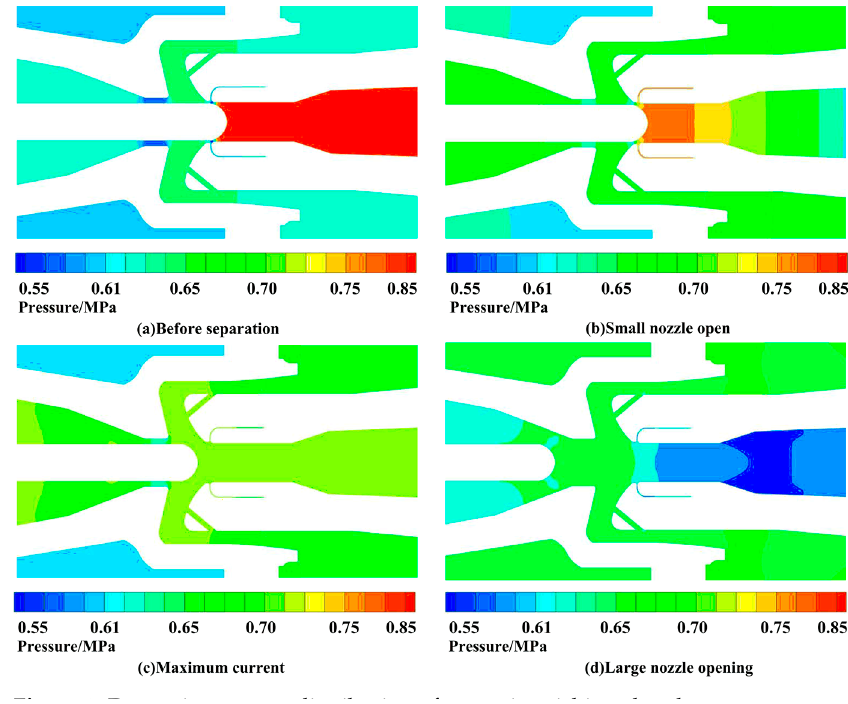
Figure 3. Dynamic pressure distribution of arc extinguishing chamber.